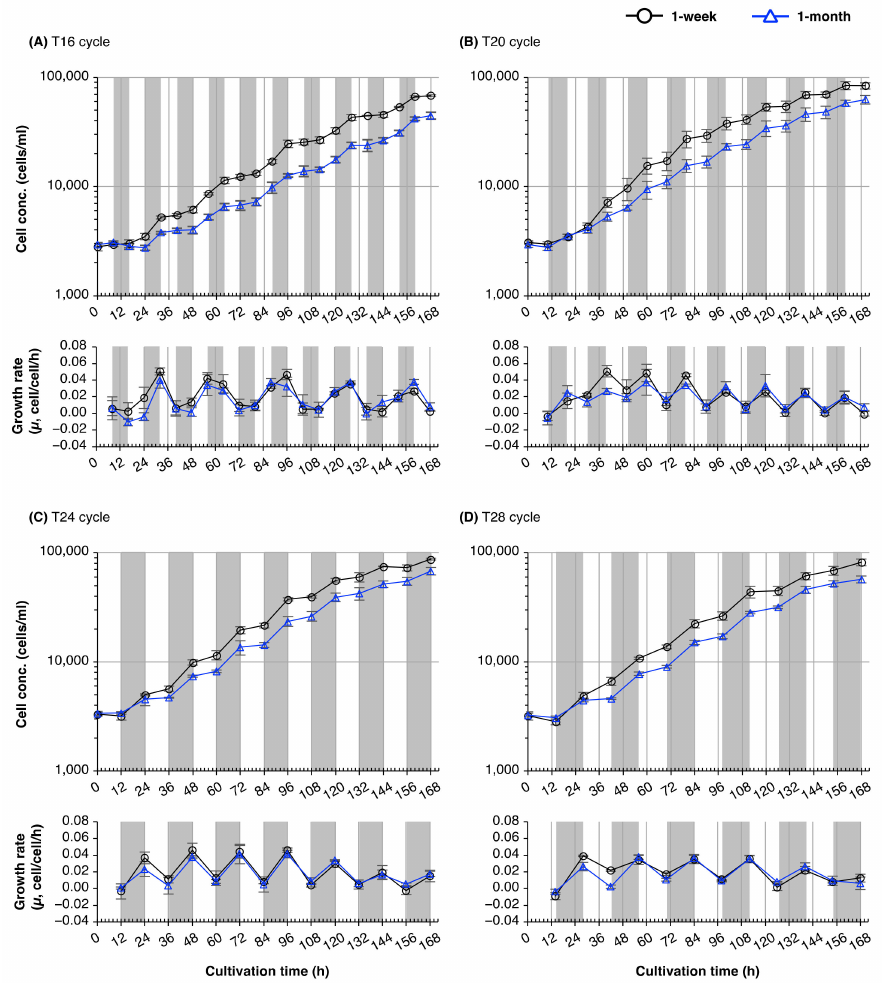
Figure 2. Effect of non-24-h light/dark cycles (T-cycles) on increases in cell numbers of E. gracilis from cultures of different ages. ( A – D ): Time courses of cell concentration (upper panels) and growth rate ( µ , cell/cell/h) (lower panels) of E. gracilis cells from 1-week- and 1-month-old cultures under ( A ) T16; ( B ) T20; ( C ) T24; and ( D ) T28 cycles. E. gracilis cells were cultured under T24 cycles for 1 week or 1 month, and subsequently inoculated into fresh medium. The algal cells were then cultured under the different T-cycles for 7 days. Data are means ± SD ( n =